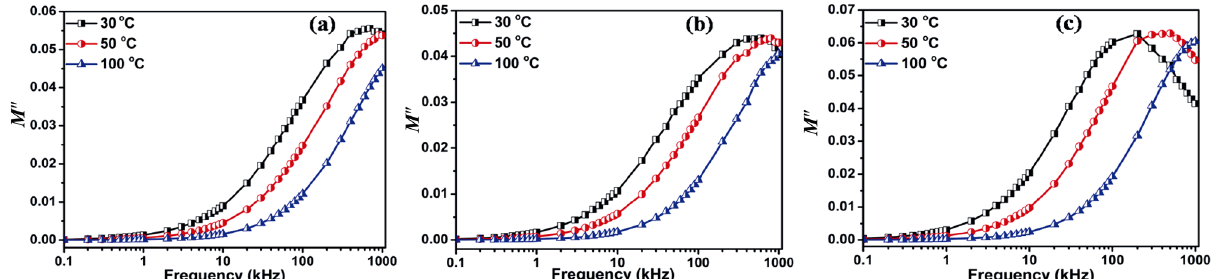
Fig. 7 Variation of imaginary part ( M ʹʹ ) of modulus with frequency for (1 ̶ x )KNN–( x ) BHF composites: (a) x = 30 wt%, (b) x = 40 wt%, and (c) x = 50